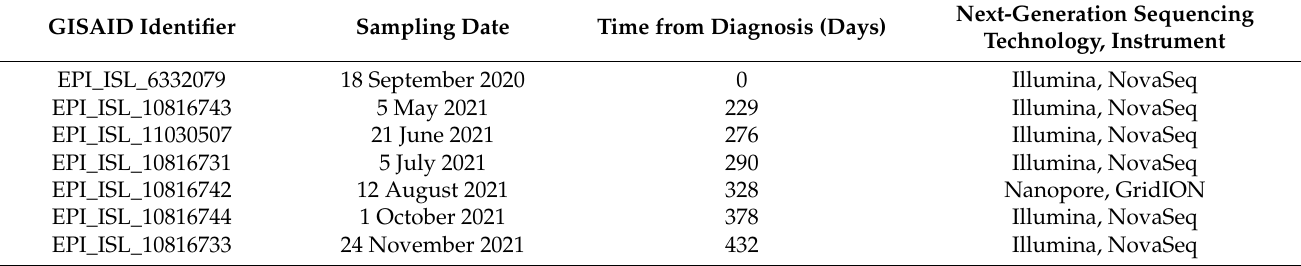
Table 1. Genome sequences obtained from the sequential nasopharyngeal samples of the case-patient.